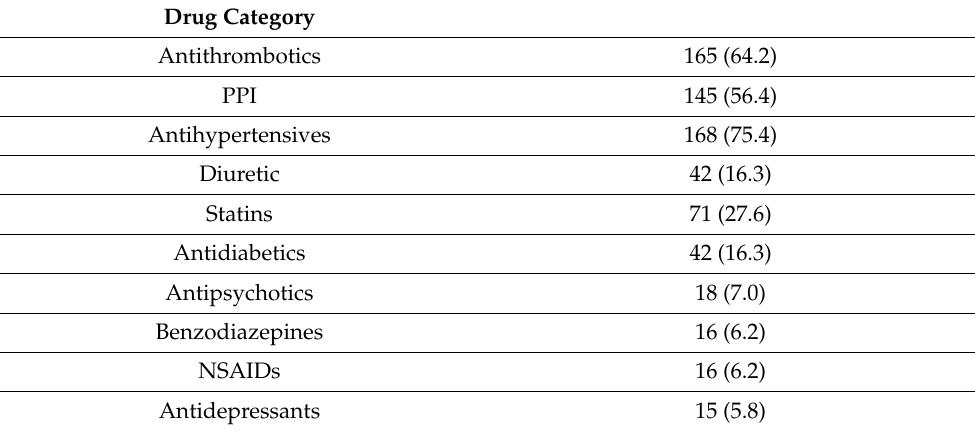
Table 2. Categories of medications prescribed on admission.